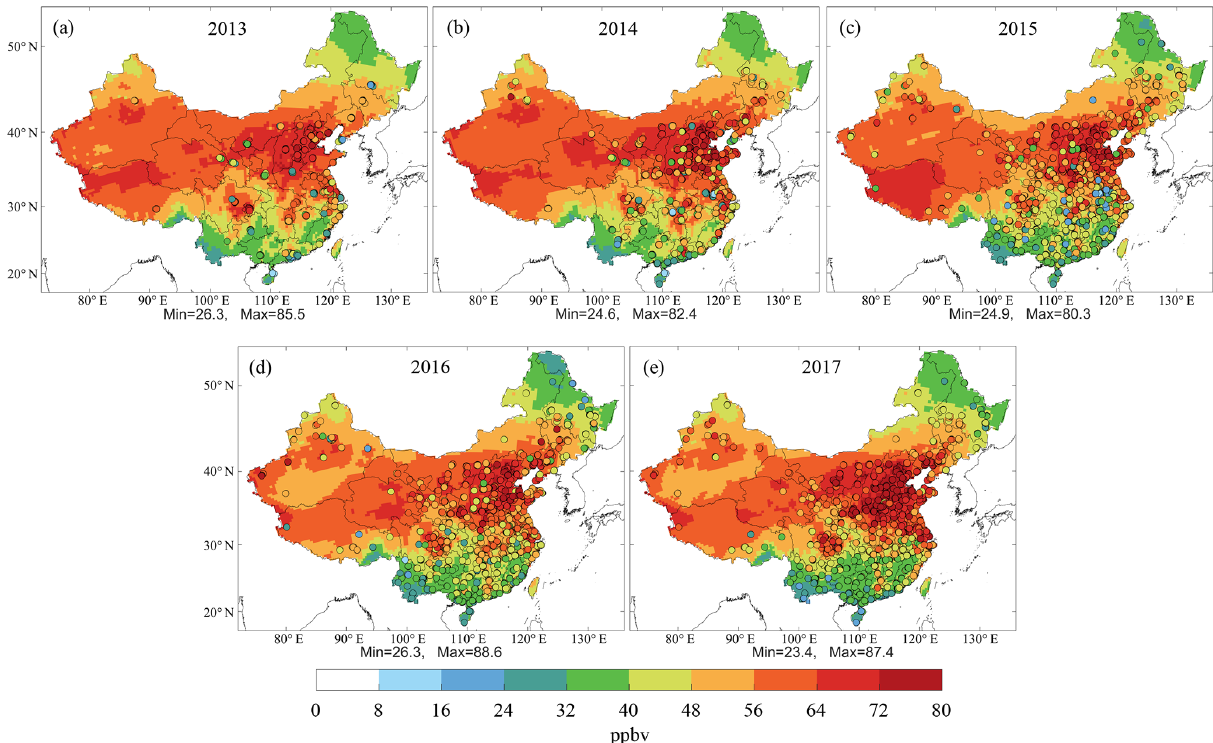
Figure 1. Spatial distribution of the simulated surface maximum daily 8h average (MDA8) O 3 mixing ratios in summer (June–August) of 2013 (a) , 2014 (b) , 2015 (c) , 2016 (d) , and 2017 (e) . Circles with color are the available observed values at environmental monitoring stations in each